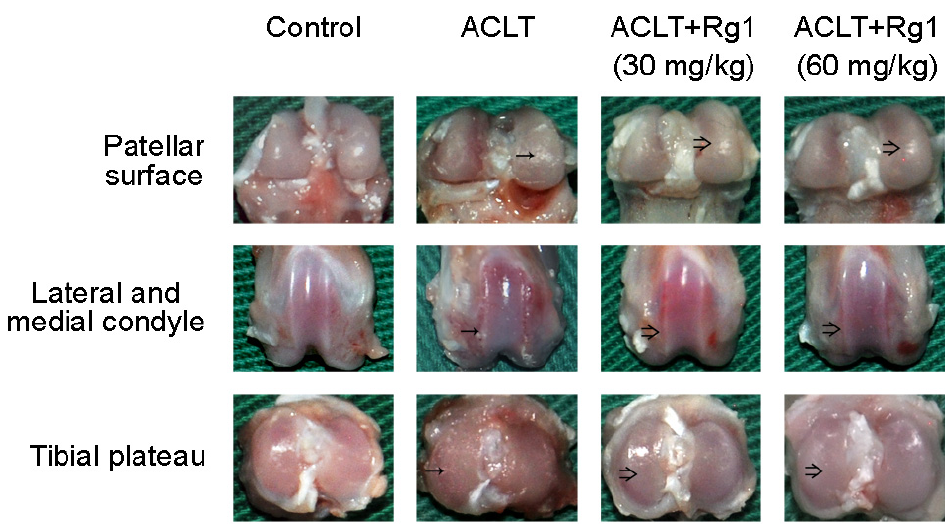
Figure 3. Rat OA and gross morphology. OA was induced by Anterior Cruciate Ligament Transaction (ACLT) of the right knee. Four weeks after ACLT, Rg1 intervention groups received Rg1 (30 or 60 mg/kg/day) by gavage once daily for eight consecutive weeks. Gross morphological changes of femoral condyles and the tibial plateau were photographed to compare cartilage lesions at 12 weeks after surgery. “ → ” indicates articular surface abrasion; “ ⇒ ” indicates articular cartilage repair.